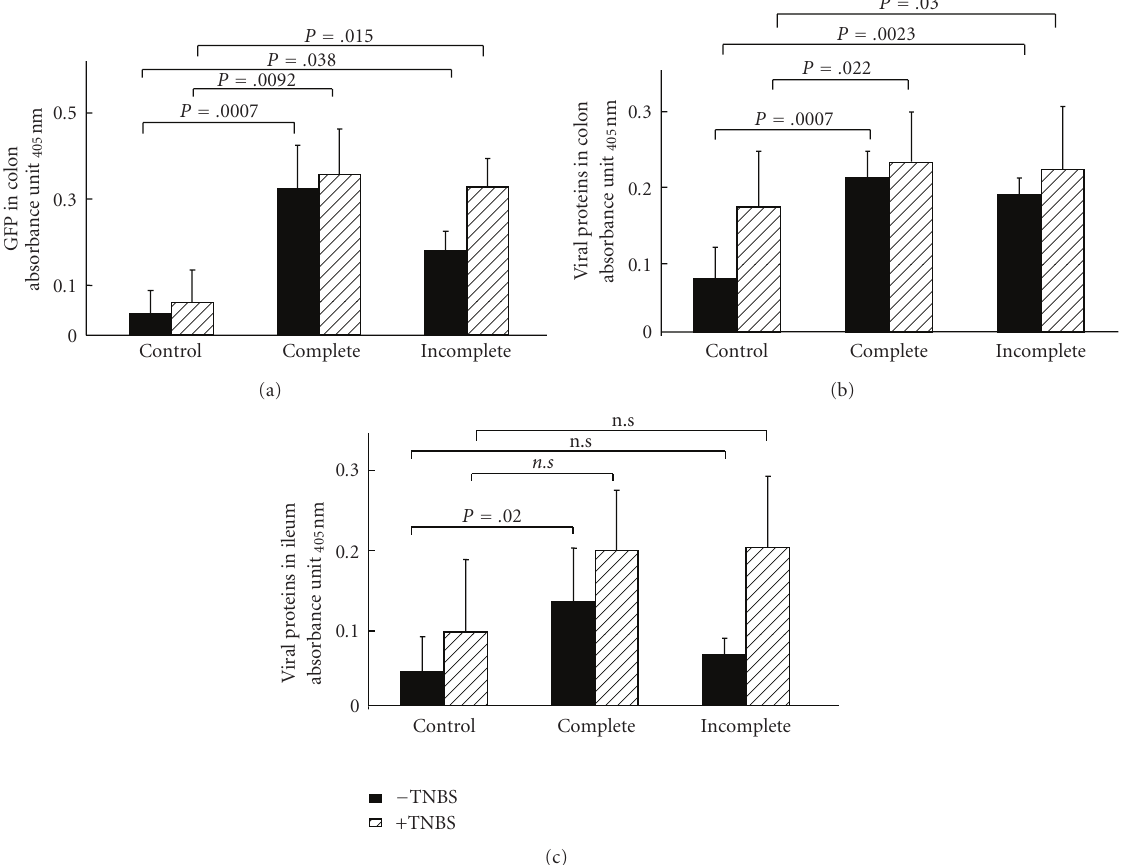
Figure 7: Complete or incomplete VLP delivery to the normal or inflamed gut. Delivery of GFP (a) and viral proteins (b) to the colon and of viral proteins to the ileum (c) from healthy and TNBS-treated mice ( n = 4) was evaluated by ELISA assays. Results are expressed as absorbance units and are the mean ± sd of three experiments. Dunnett’s test was used to compare treatments with the control